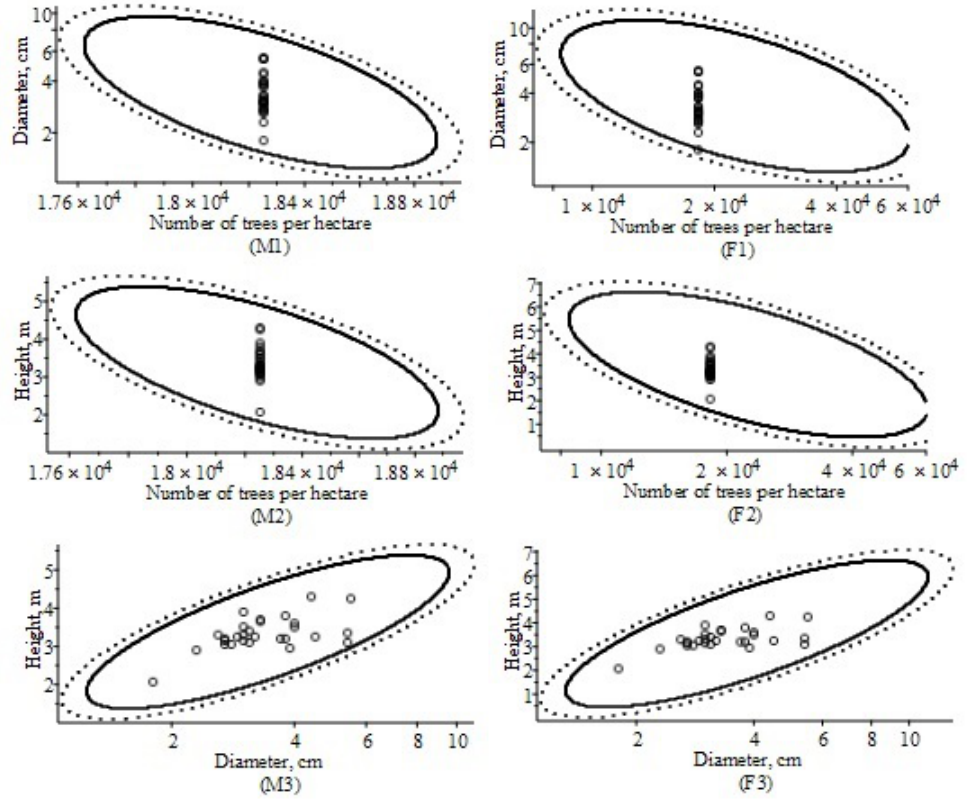
Figure 4. The tolerance regions with the observed data point (represents the same stand as in Figure 3) for stationary bivariate probability density functions ( γ = 0.95): ( M1 – M3 ) mixed e ff ects scenario; ( F1 – F3 ) fixed e ff ects scenario; tolerance level β = 0.90, solid line; tolerance level β = 0.95, dotted